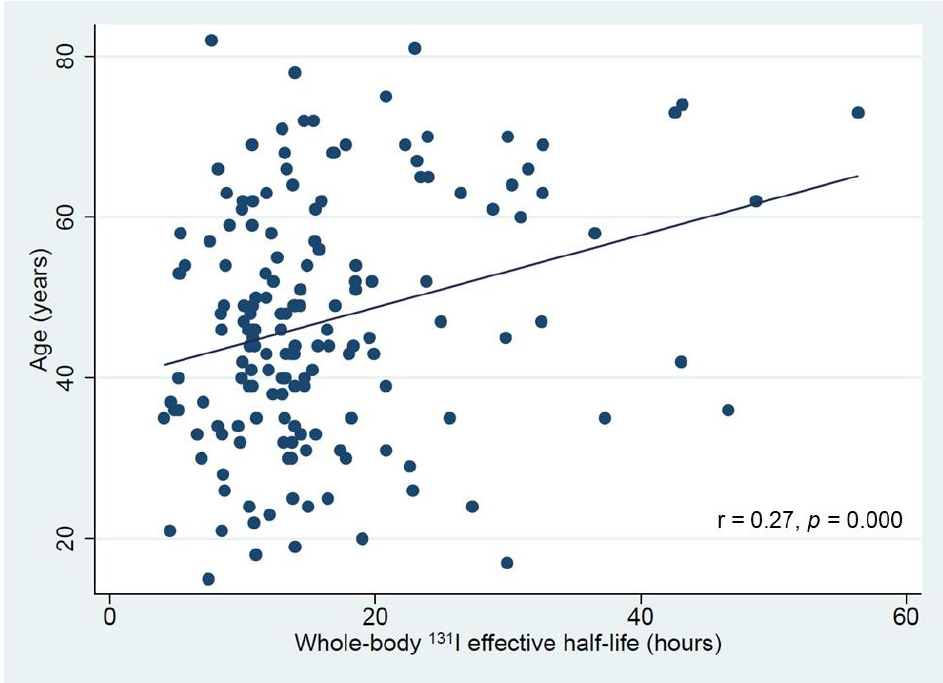
Figure 2. Relation between whole-body effective 131 I half-life and age in patients with differentiated thyroid cancer.